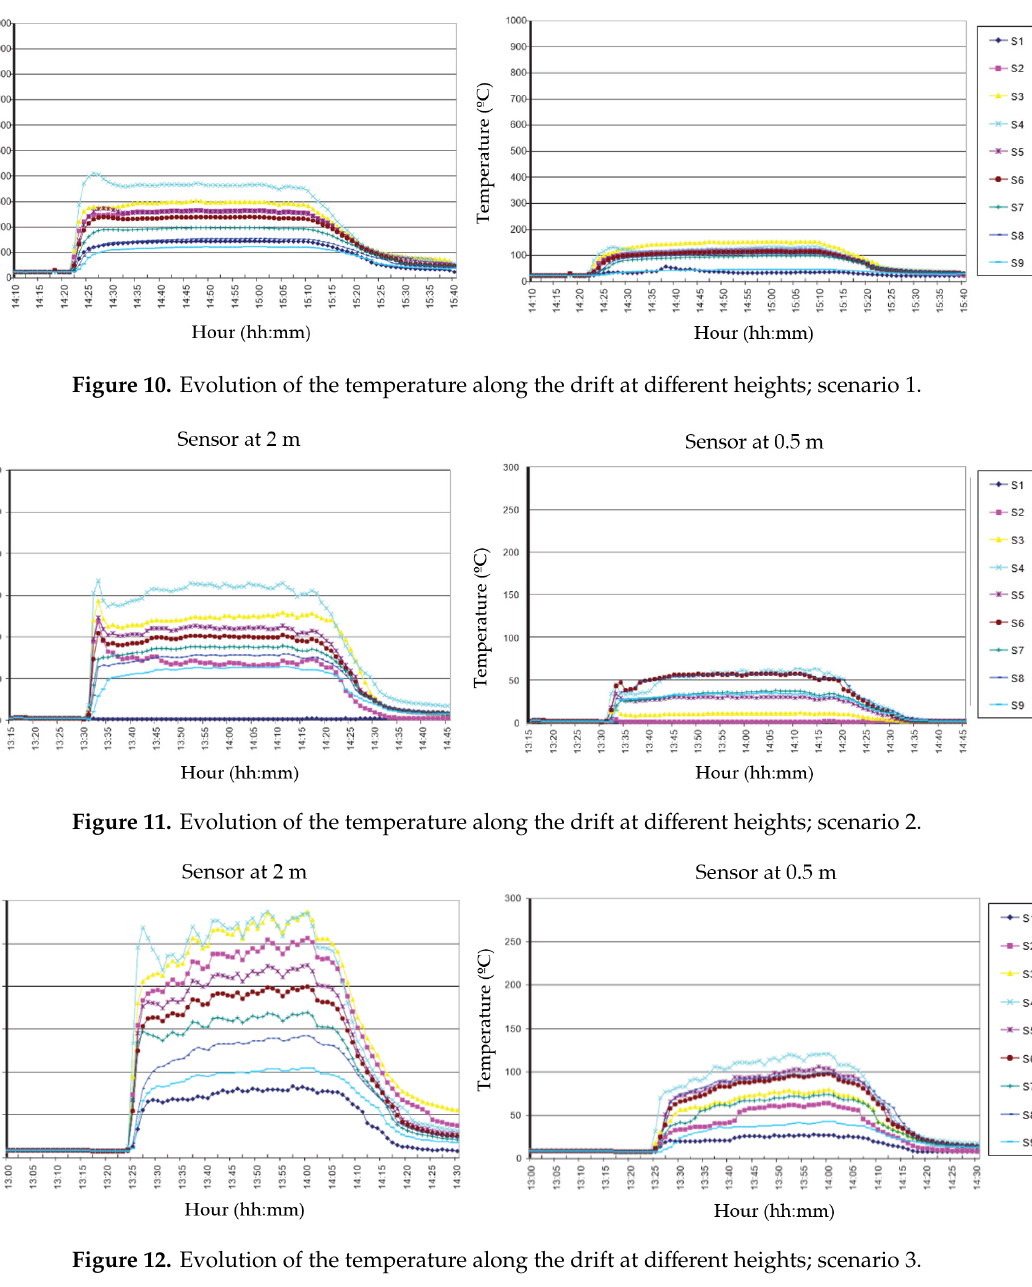
Figure 13. Evolution of the temperature along the drift at different heights; scenario 4. Figure 14. Evolution of the temperature along the drift at different heights; scenario 5. The temperature evolution displayed a similar trend: a rise in temperature followed by a stable period of maximum temperature and then a progressive decrease as the fire faded. However, there was an important divergence if it was compared the period from which the temperature increased because of the fire. The temperature increase was recorded earlier than pollutants in E1 and E2, while, in E3 and E4, the opposite occurred and E5 showed an almost identical start for temperature and pollutants. On the other hand, a phenomenon already mentioned in the previous figures was observed upon analyzing the behavior of the flow. Shortly after reaching the maximum fire power, there was a decrease in the temperature until it reached a stable level. This was due to the fire acting as a resistance in the ventilation circuit at the beginning, as can be seen in the sensors close to the fire: S2, S3, and S4. This phenomenon indicates that there was an advance of the fumes in the opposite direction of the flow during this period, i.e., a roll-back [8], being more pronounced in the case of